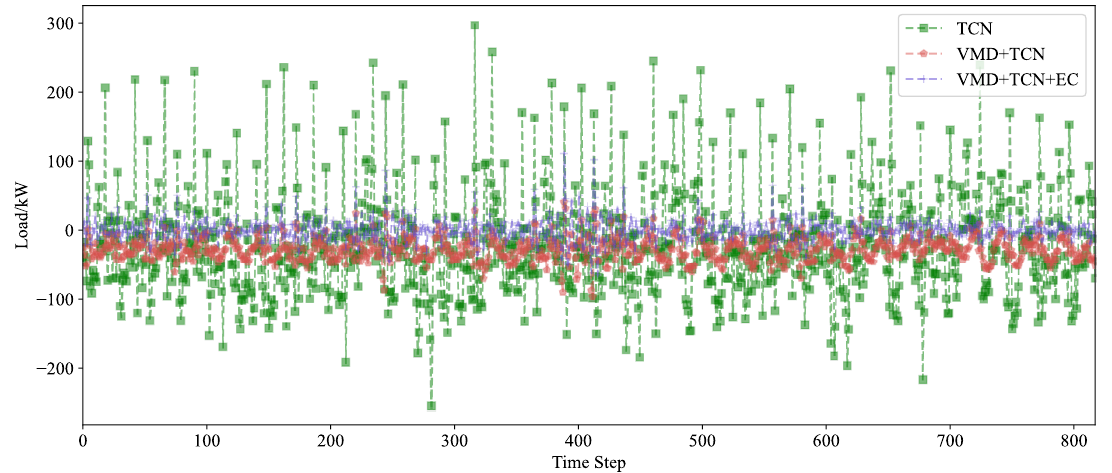
Figure 12. Mean absolute error comparison of different models on the test set.